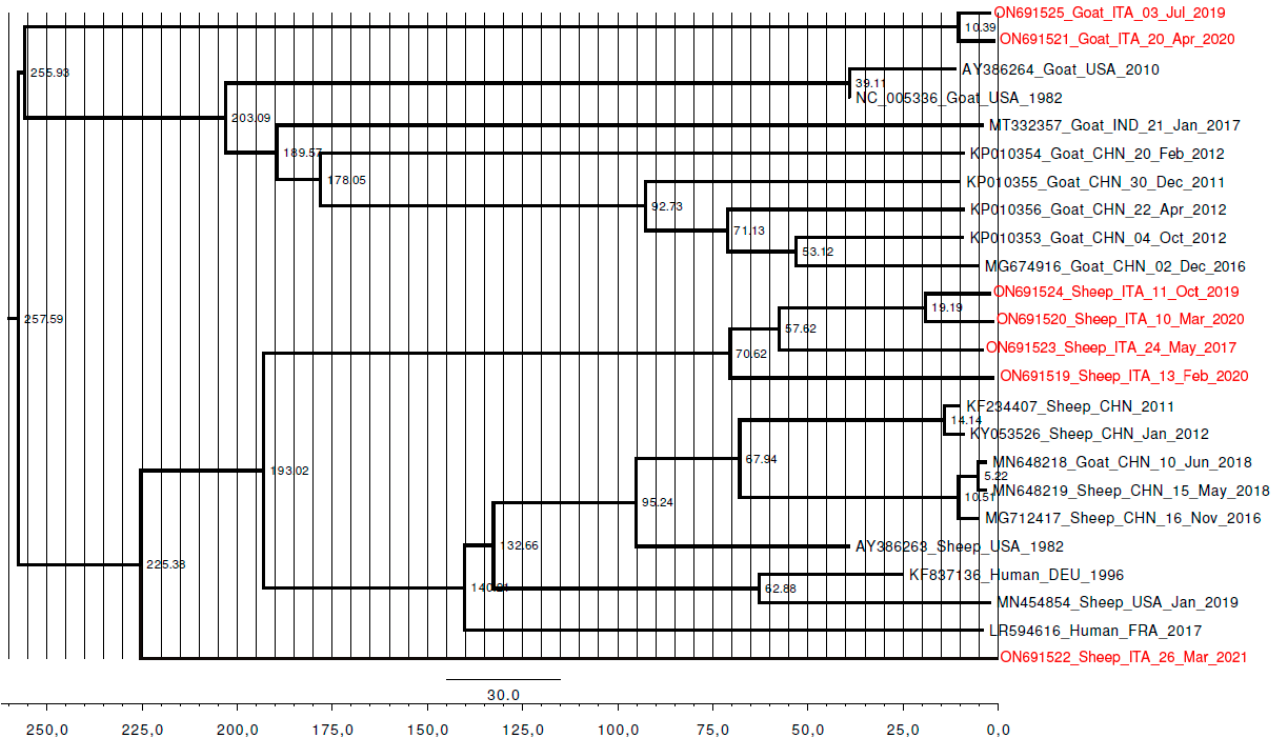
Figure A1. Bayesian phylogenetic time-scaled maximum clade credibility tree based on all ORF virus whole genomes used in the present study. All nodes of the tree are highly supported by values of posterior probabilities ≥ 0.95. The Sardinian sample codes are reported in red font. The codes of sequences report the GenBank accession number, the country acronym, and the presumptive year of isolation. The numbers at the nodes refer to the confidence interval (C.I.) 95% highest posterior density (HPD) for the dating of the cluster. Capital letters on the right refer to the genetic clusters indicated in Figure 1. Horizontal bar indicates the years before 26 March 2021 on a temporal scale.